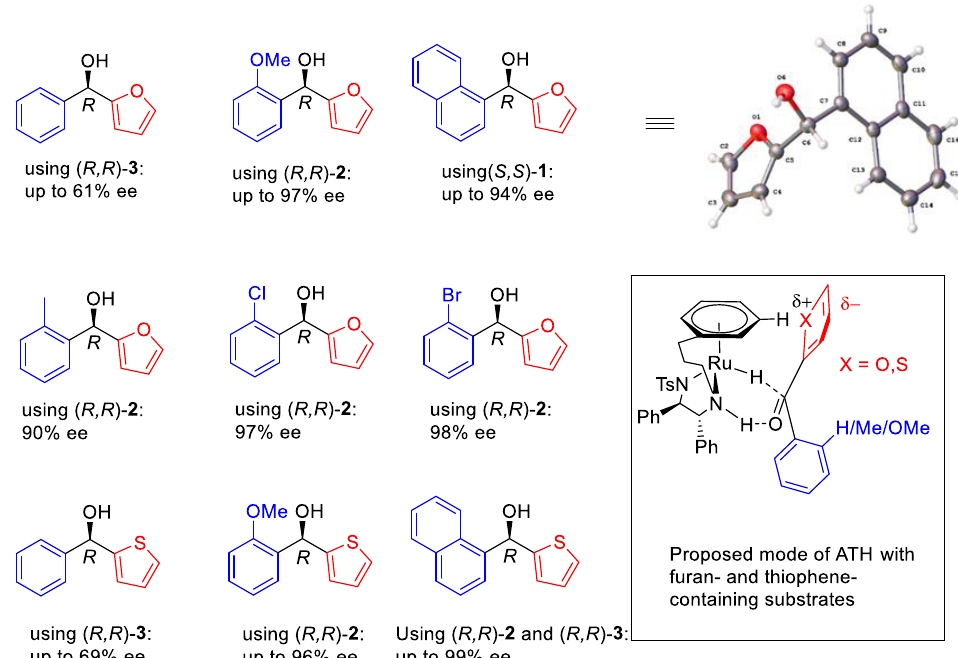
Figure 17. ATH of aromatic/heterocyclic ketones in this product.